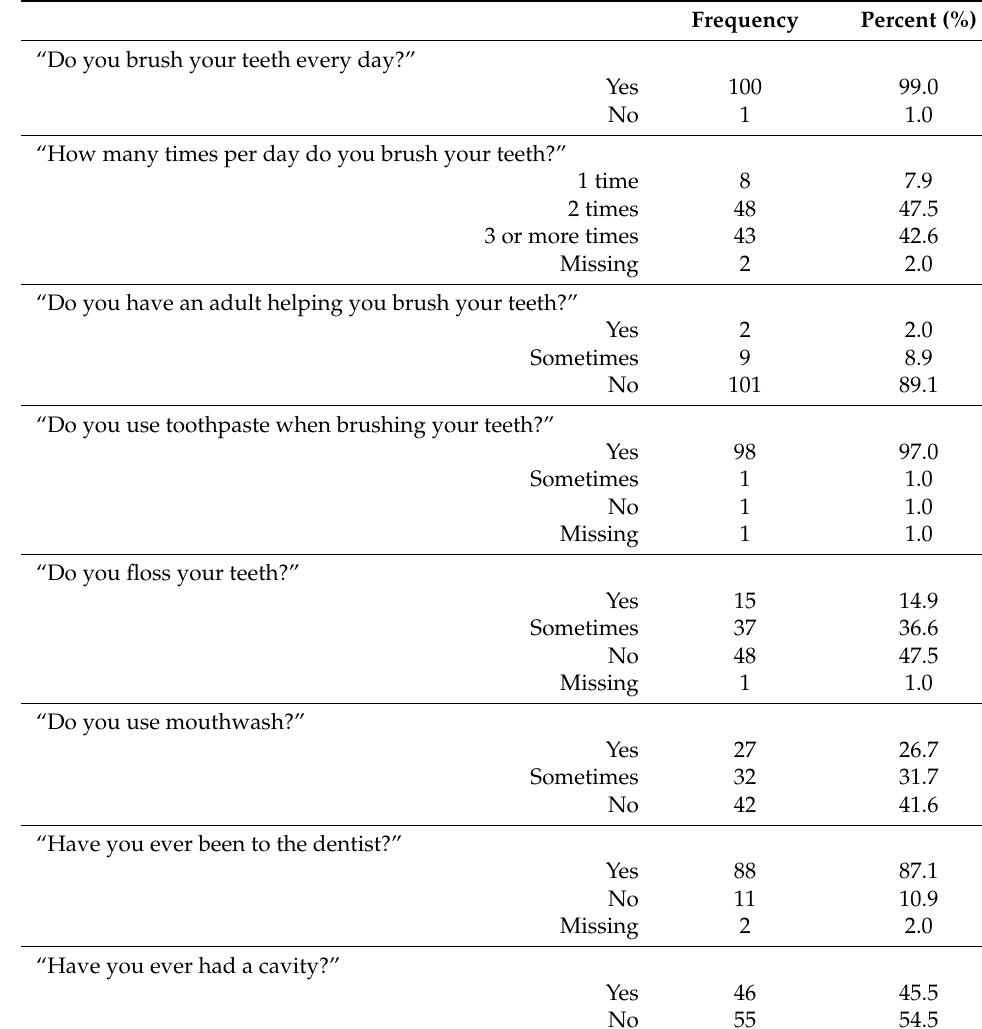
Table 1. Frequencies and percentages of children’s responses about their dental habits and